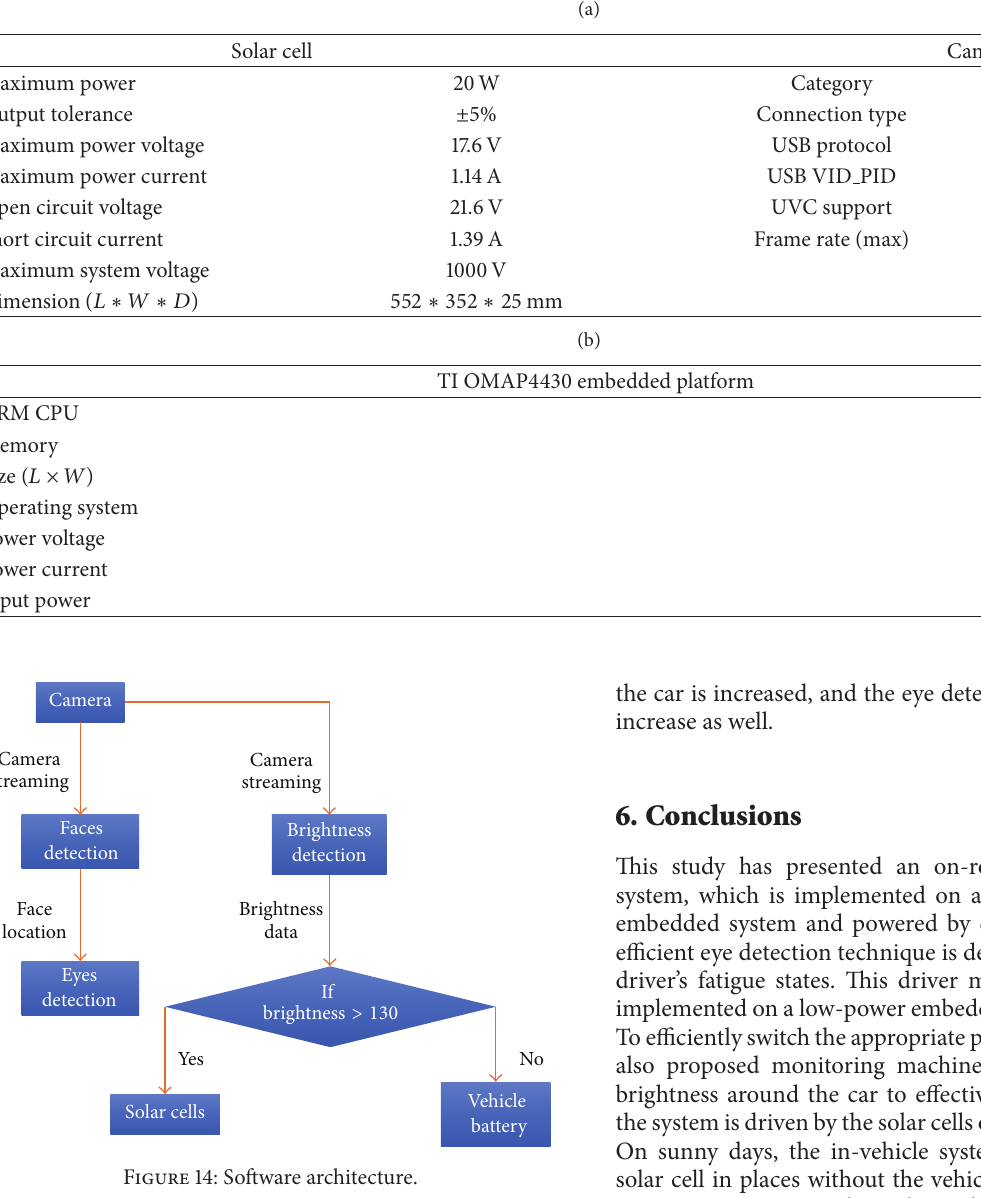
Table 2: Specification of driver monitor system.